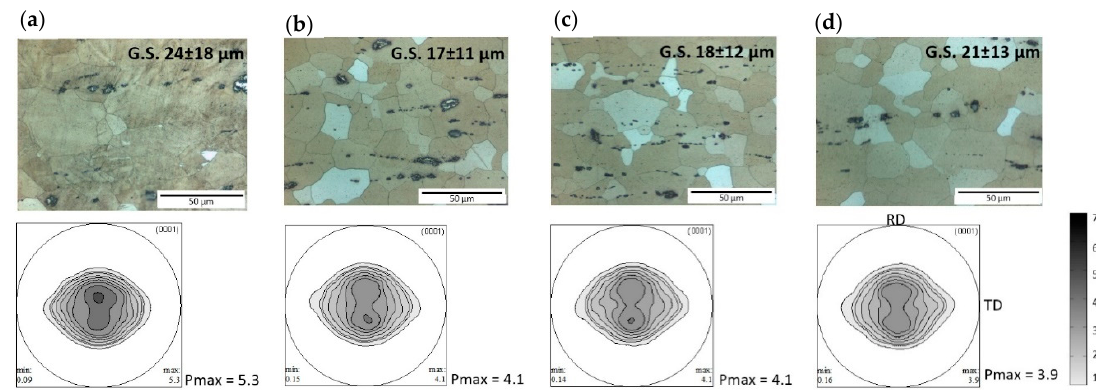
Figure 2. The optical micrographs and the recalculated (0002) pole figures of the sheets rolled by the 450-dec rolling scheme, i.e., the decreasing deformation degrees with rolling step, ( a ) at the as-rolled condition and after annealing for ( b ) 300 s, ( c ) 600 s and ( d ) 3600 s at 400 °C.